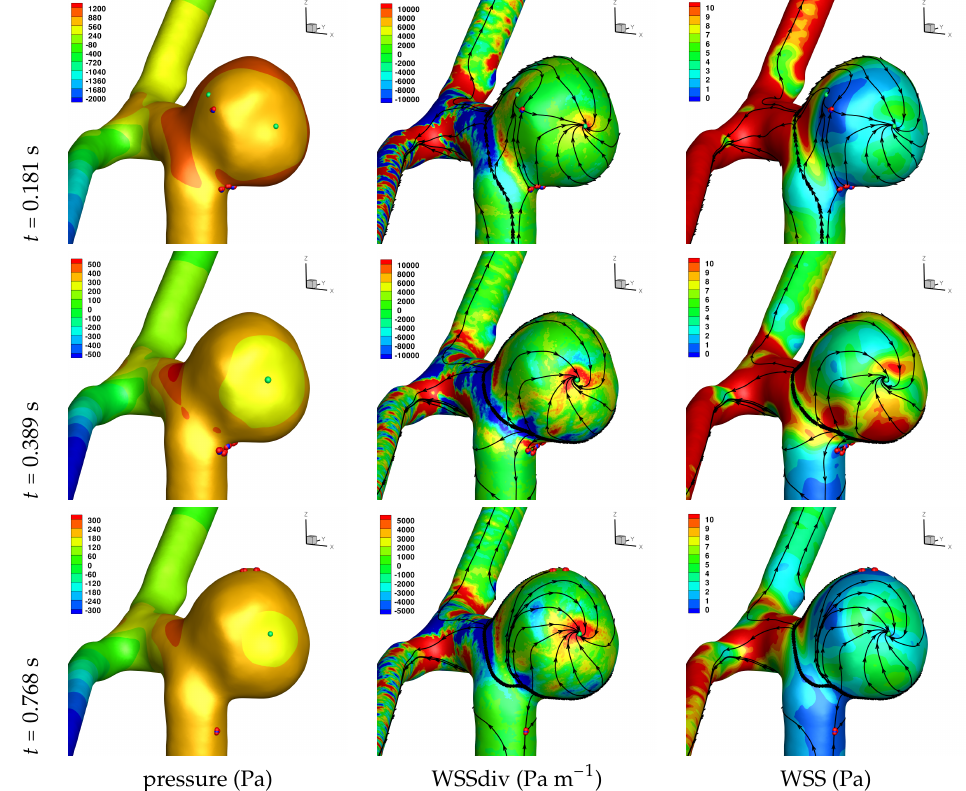
Figure 5. Solution for Case 2. Plots of surface shear lines and WSS critical points (colouring scheme as in Figure